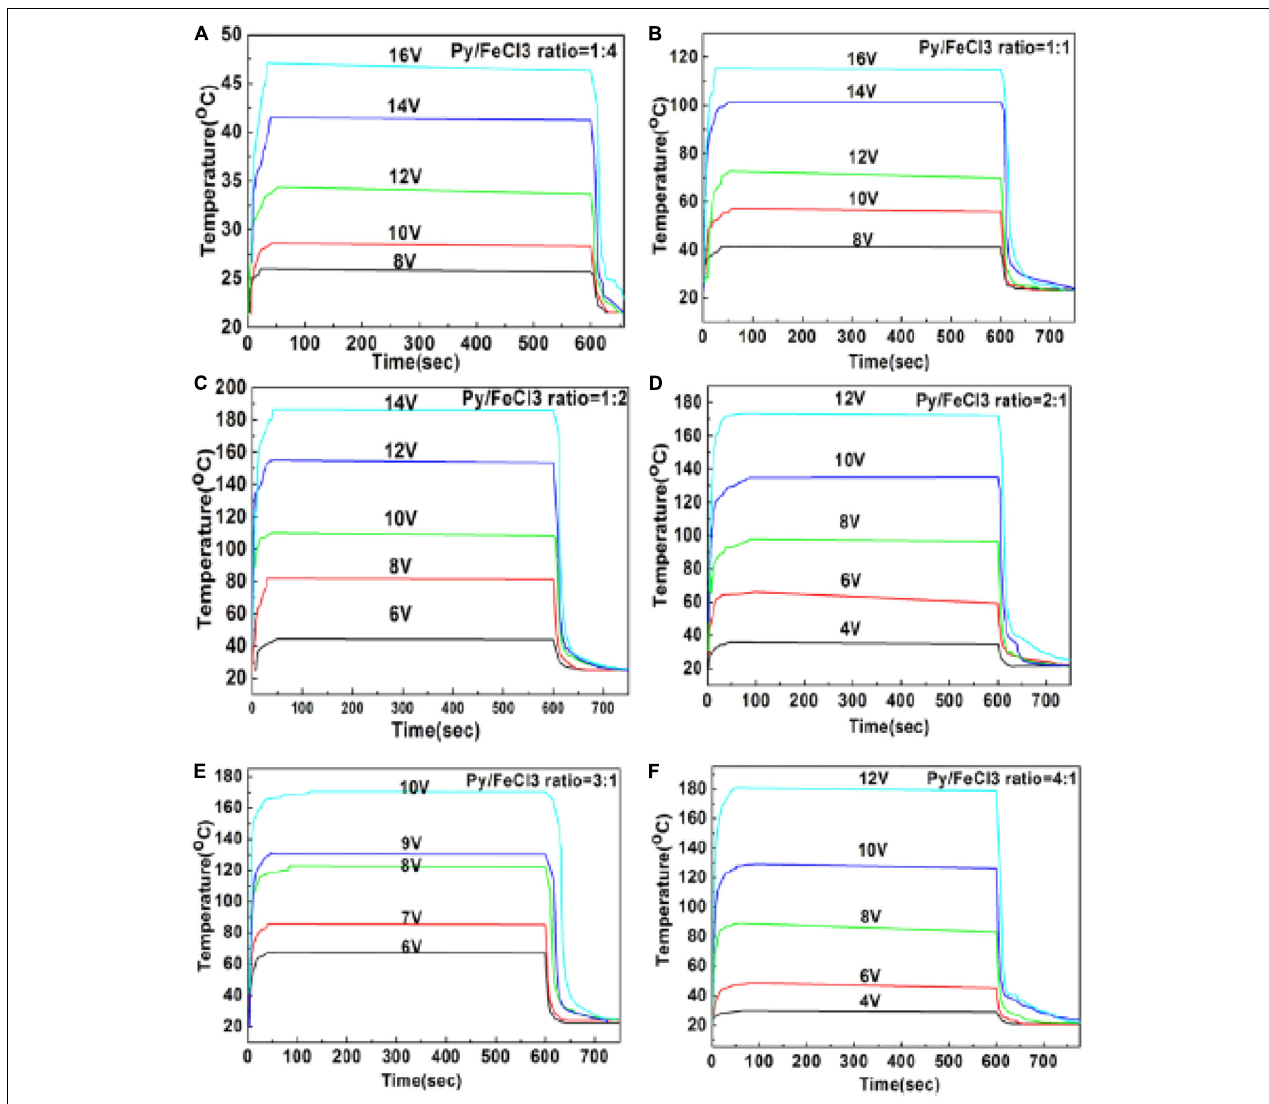
FIGURE 2 | Temperature–time curve changes of PPy/cotton composites with different Py/FeCl3 ratios (A) 1:4, (B) 1:1, (C) 1:2, (D) 2:1, (E) 3:1, and (F) 4:1 at different applied voltages of 1–16 V. Reproduced from Xie et al. (2019) under the Creative Commons CC-BY